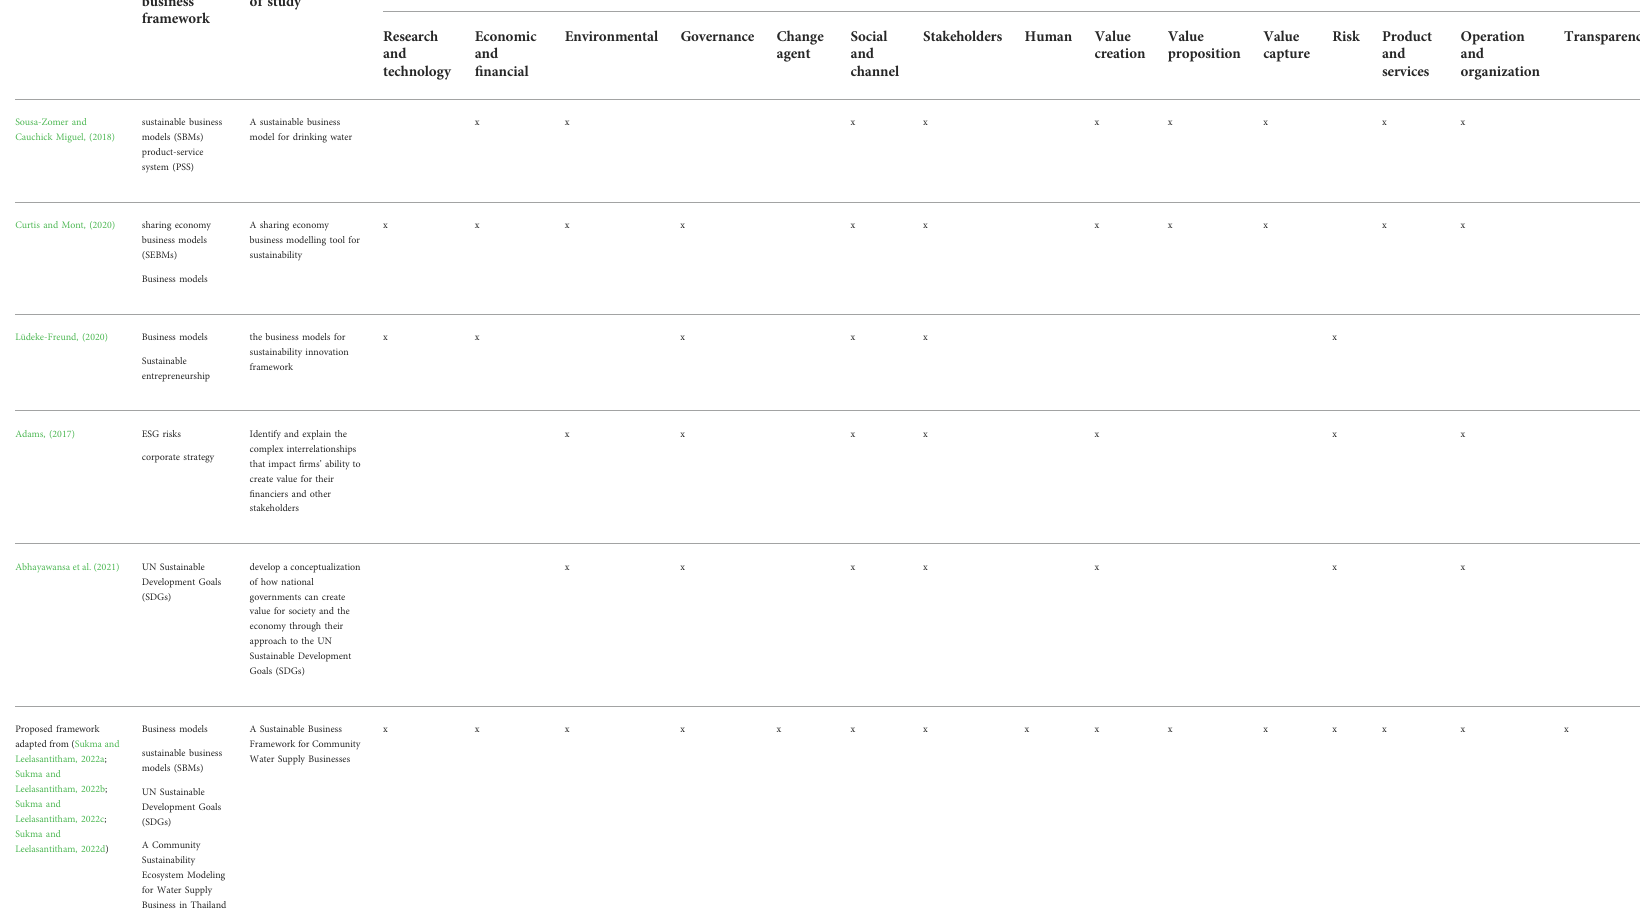
TABLE 6 ( Continued ) A review of the literature for comparison and